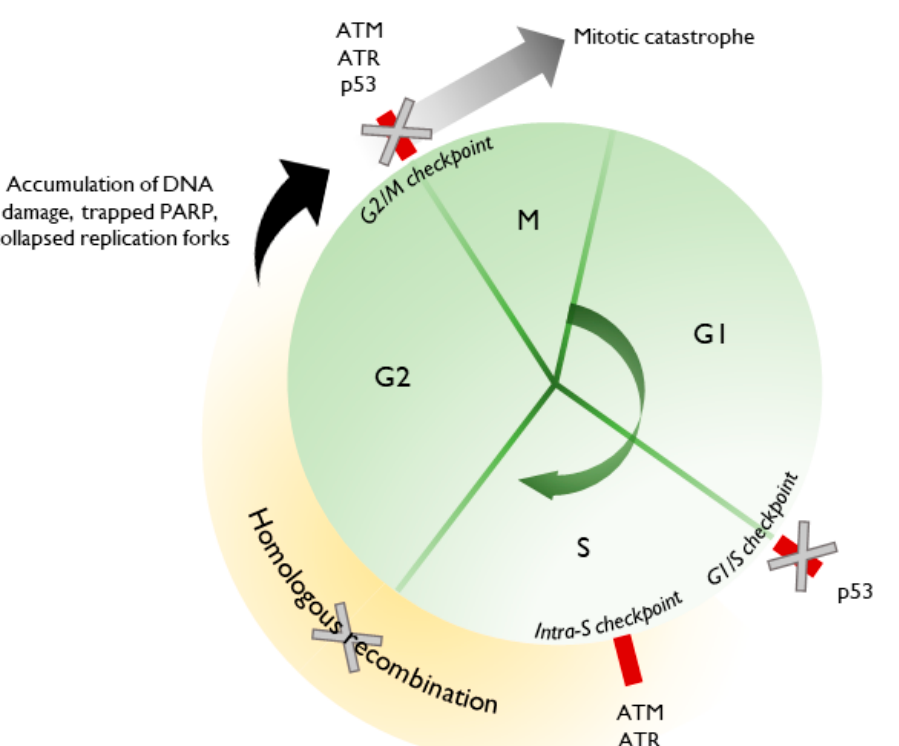
Figure 2. Rationale for re-sensitization to PARPi. Almost all HGSOC harbor mutant p53, with cell cycle dysregulation at baseline. Inhibition of ATM or ATR further prevents the appropriate halting of the cell cycle. Using agents that reestablish HR deficiency allows for the accumulation of endogenous and exogenous DNA damage, trapped PARP, and replication stress, ultimately leading to mitotic catastrophe and cell